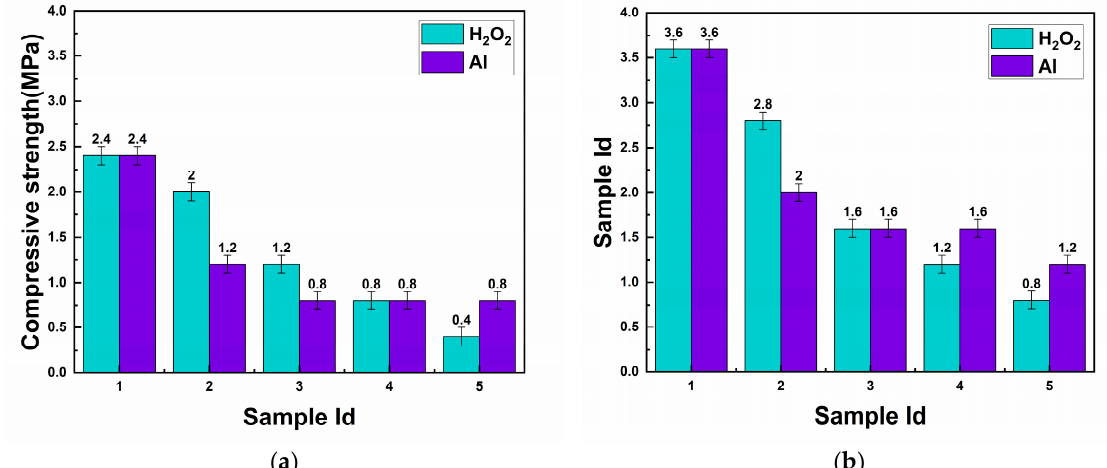
Figure 6. Effect of the type and content of the foaming agent on the compressive strength of porous geopolymers. ( a ) 3 days and ( b ) 7 days.